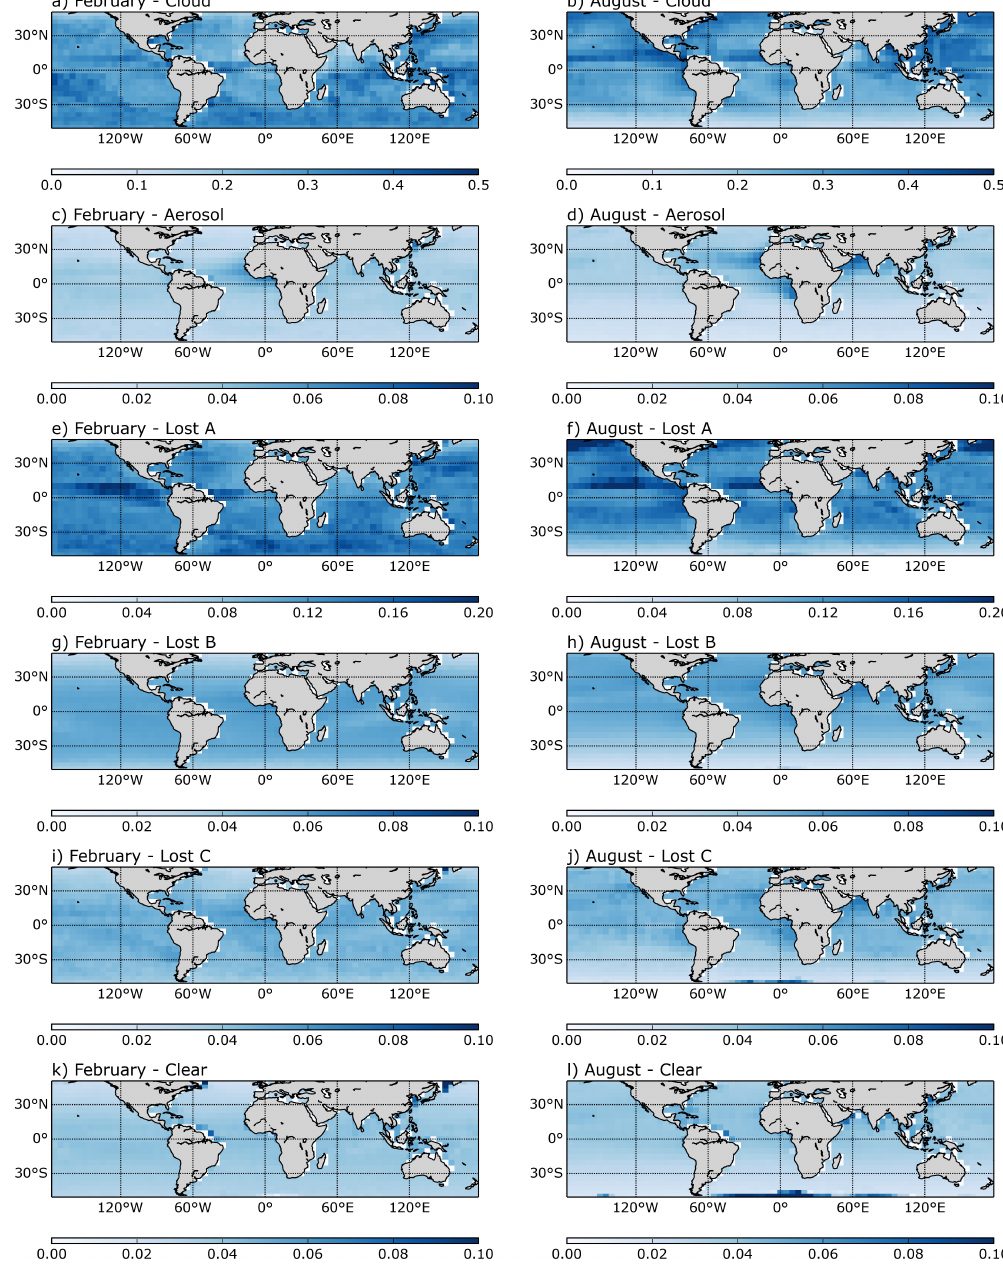
Figure 5. Mean reflectances of each class (colormaps are fitted to the range of values of each